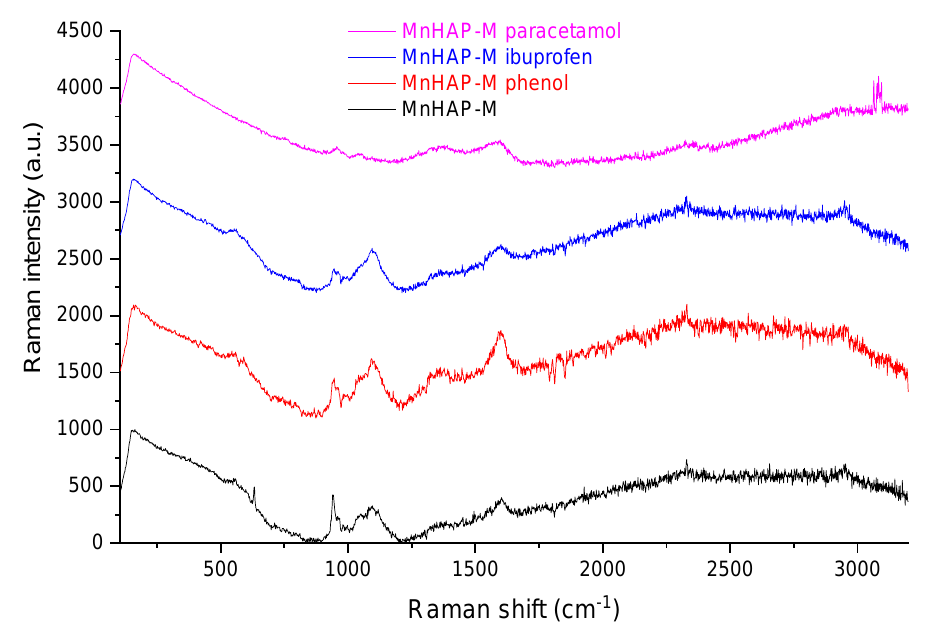
Figure 10. Raman spectra of the composite material before and after the adsorption process.